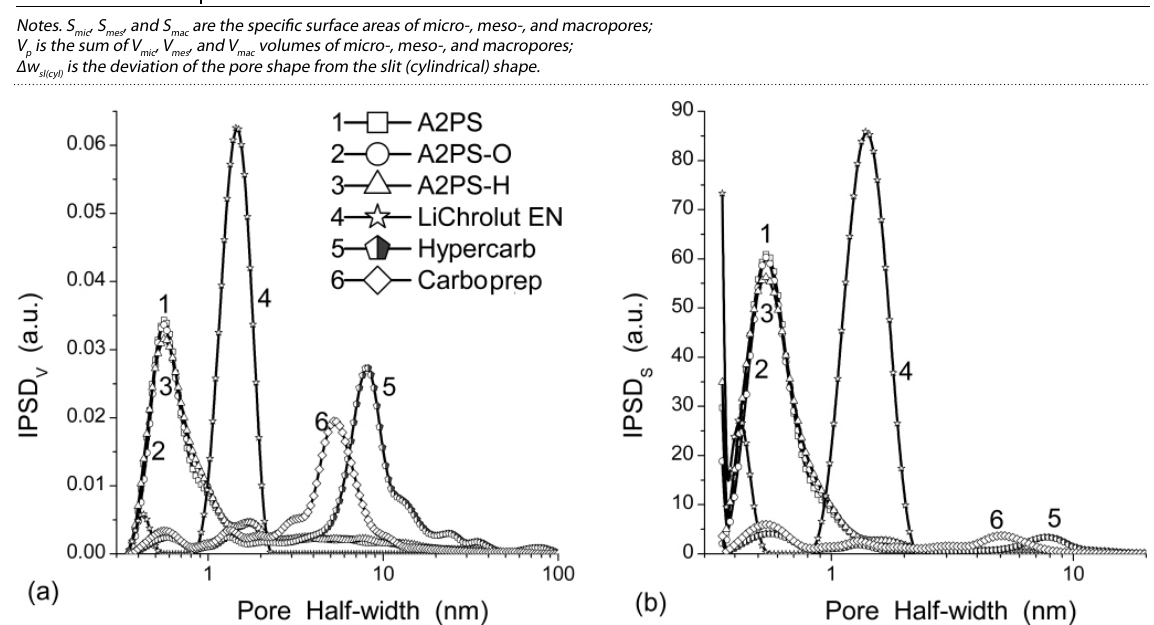
Figure 1. Pore size distributions with respect to (a) pore volume and (b) specific surface area calculated using the DFT method with the models of slit-shaped (carbons) and cylindrical (LiChrolut EN)